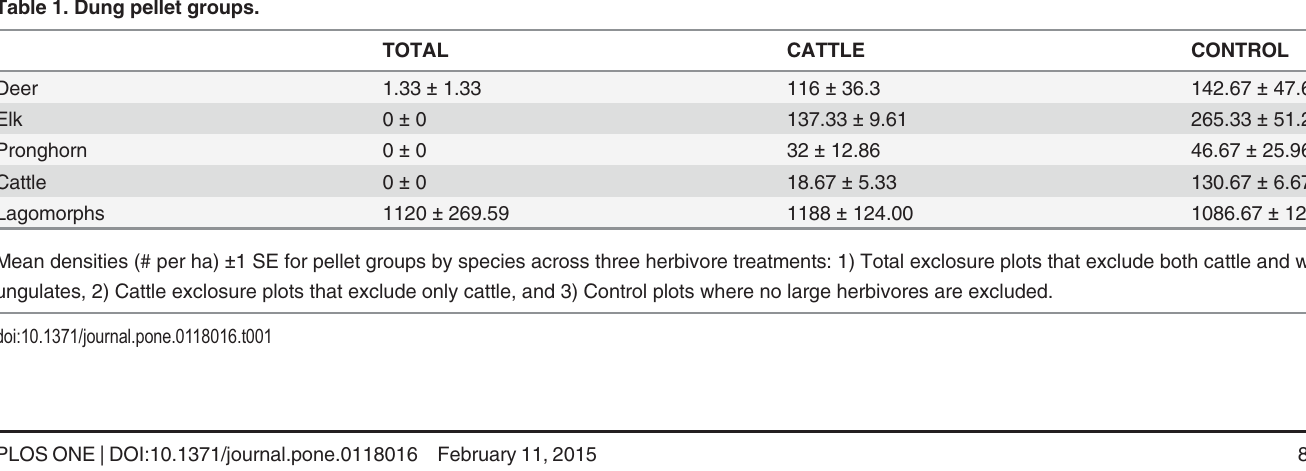
Table 1. Dung pellet groups.